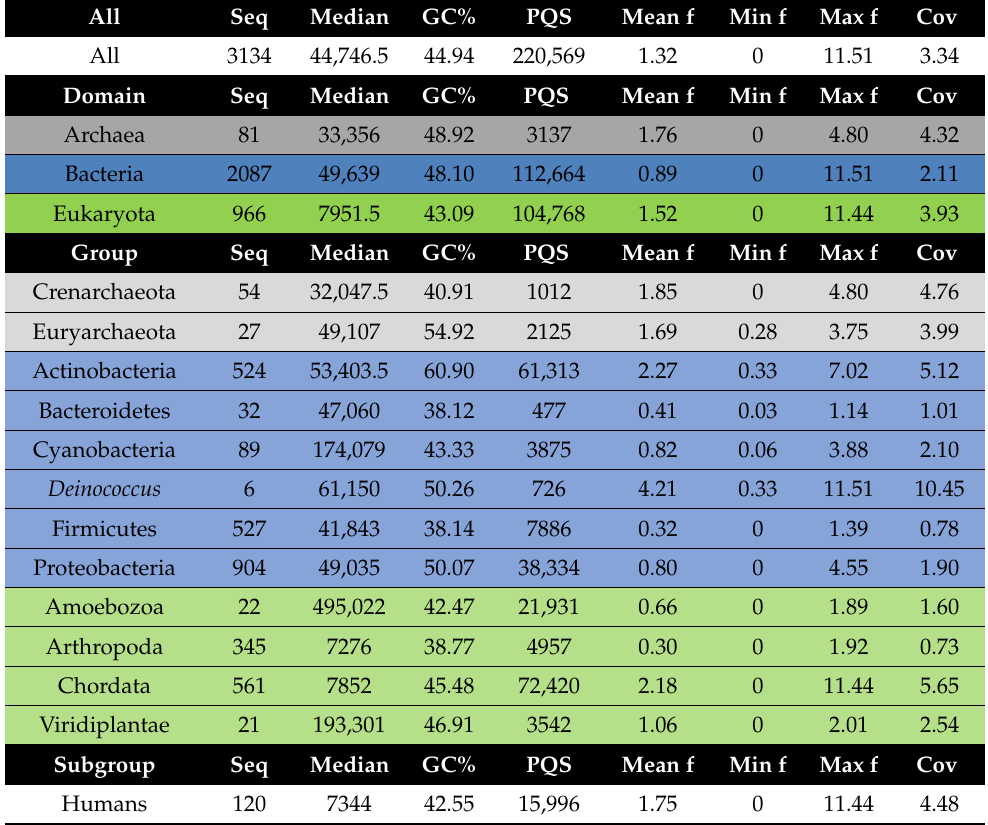
The colors correspond to phylogenetic tree depiction in Figure 1 (Grey—Archaea, Blue—Bacteria, Green— Eukaryota as host